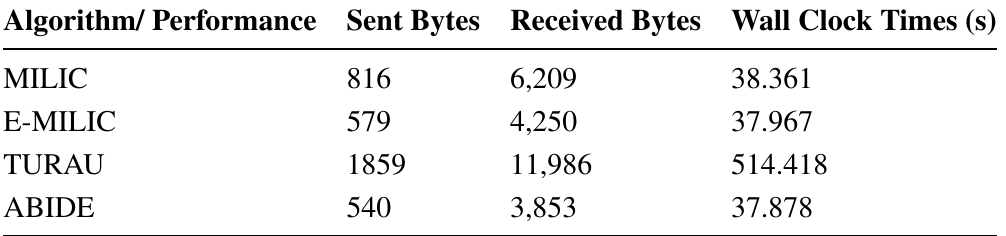
Table 4. Performance of algorithms in dense topology.